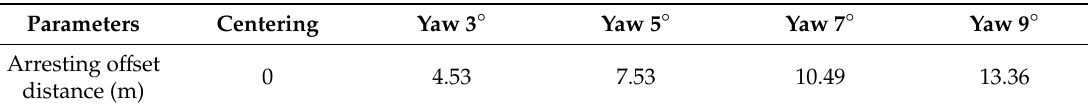
Table 5. Comparison of o ff